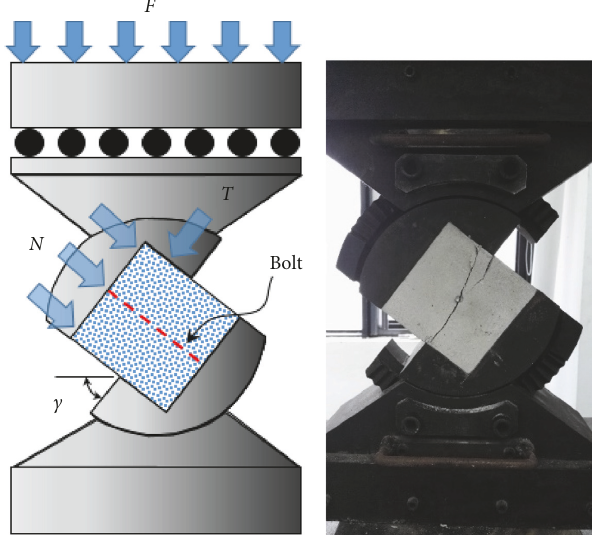
Figure 2: Oblique shear strength test device.